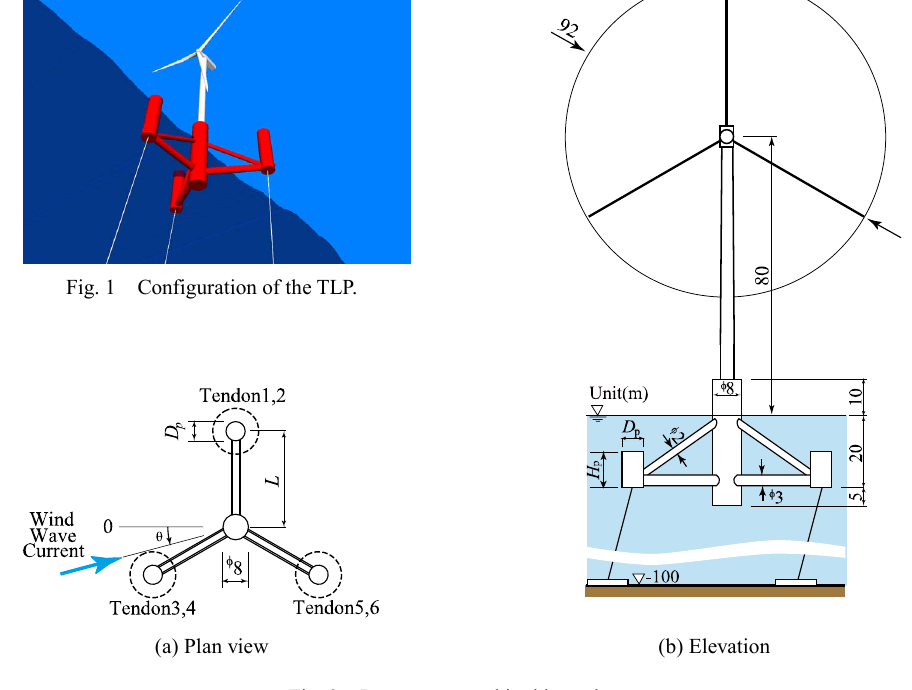
Fig. 2 Parameters used in this